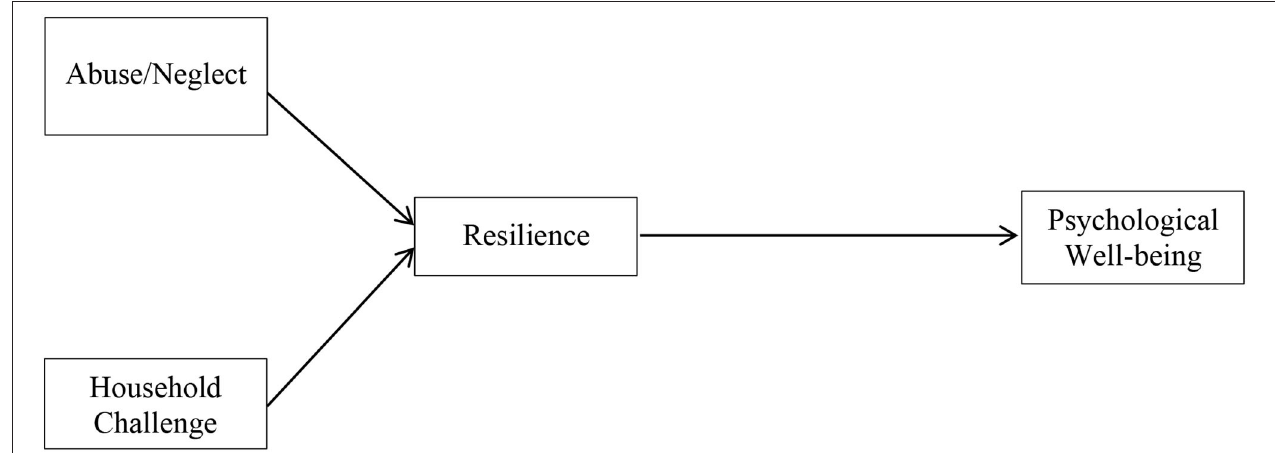
FIGURE 1 | Hypothesized model of ACE dimensions on resilience and psychological